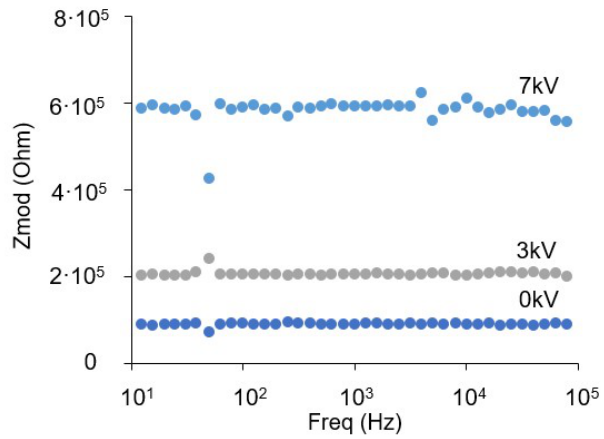
Figure 8. Impedance module vs. frequency for the ACC samples, under different applied potentials (0 kV, 3 kV, and 7 kV).